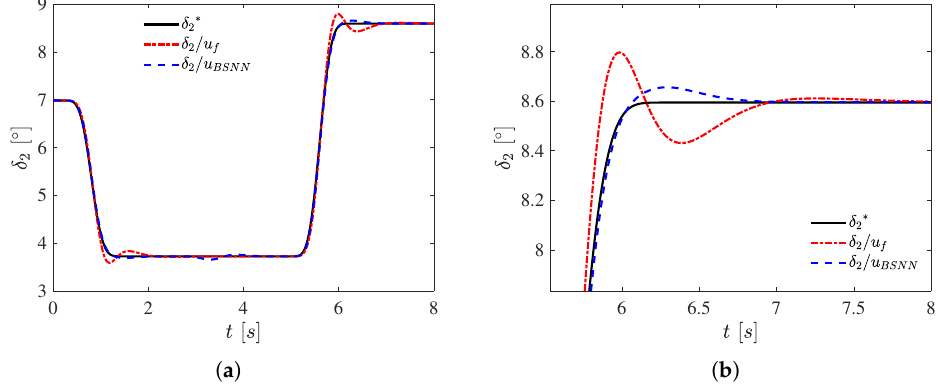
Figure 14. Load angle of generator 2 of two interconnected power systems: ( a ) δ 2 ; ( b ) zoom of δ 2 .